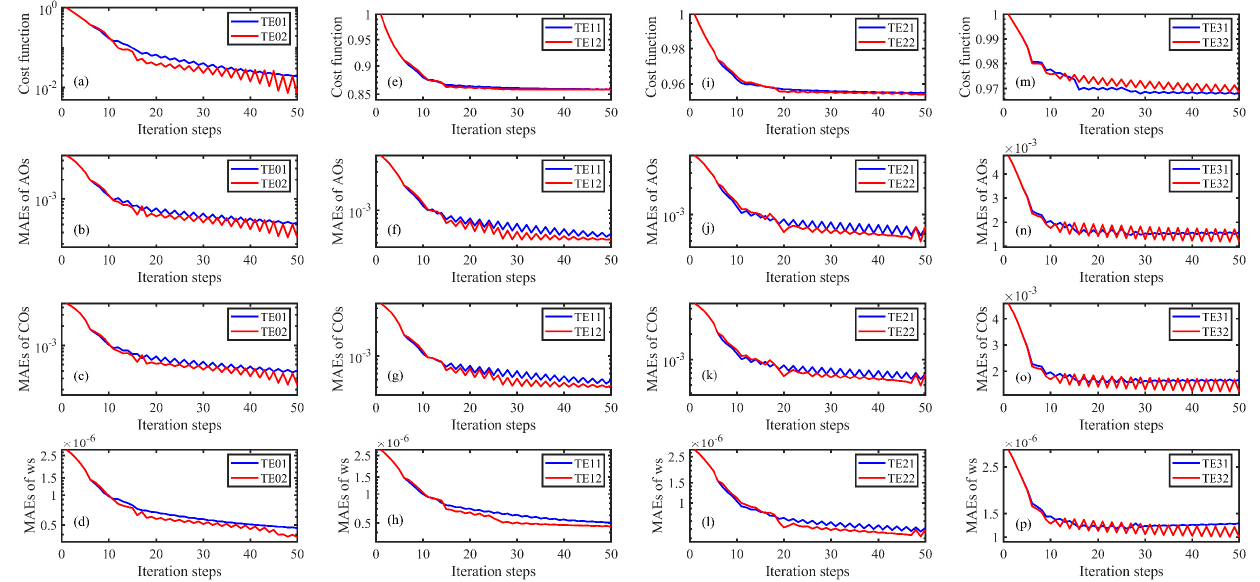
Figure 4. In twin experiments, variations of results with iteration steps in TE01 (blue line) and TE02 (red line): ( a ) normalized cost function, ( b ) MAEs between AOs and the simulated SSCs, ( c ) MAEs between COs and the simulated SSCs, ( d ) MAEs between the prescribed and estimated settling velocity. ( e – h ) same as ( a – d ) but for TE11 (blue line) and TE12 (red line), ( i – l ) same as ( a – d ) but for TE21 (blue line) and TE22 (red line), ( m – p ) same as ( a – d ) but for TE31 (blue line) and TE32 (red line). Table 2. Results of the normalized cost function, MAEs between AOs and the simulated SSCs, MAEs between COs and the simulated SSCs, MAEs between the prescribed and estimated settling velocity w s , and DPEI in the twin experiments.